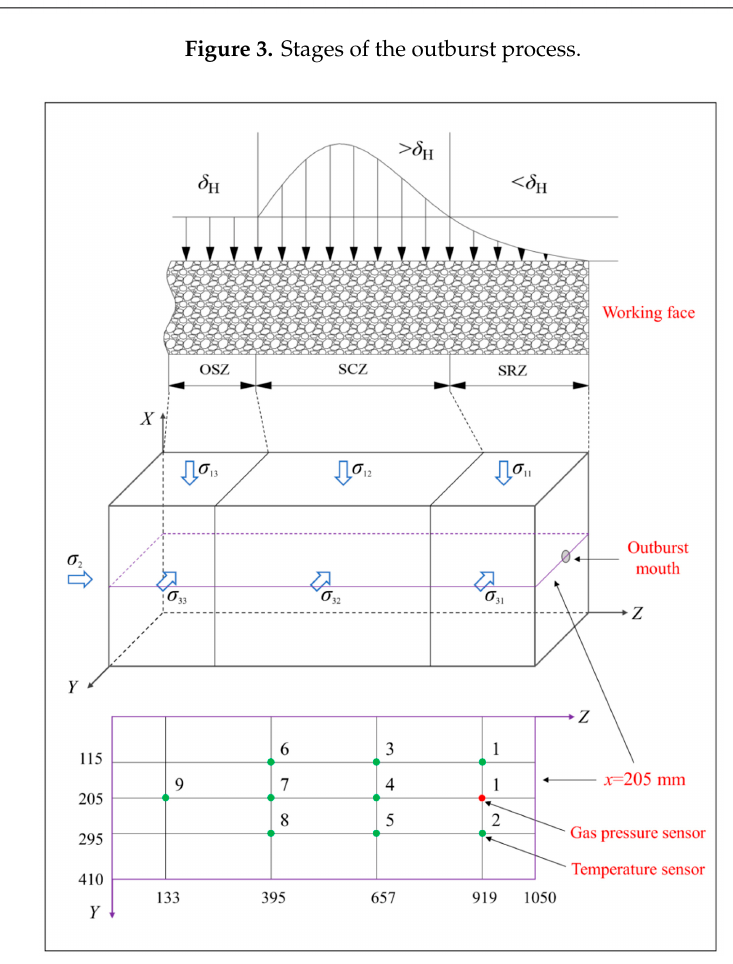
Figure 4. Distribution diagrams of three stress zones and temperature sensors (units: mm; δ H means the stress in the original stress zone and σ ij means the stress loaded in three directions during experiments, i , j = 1, 2, 3).